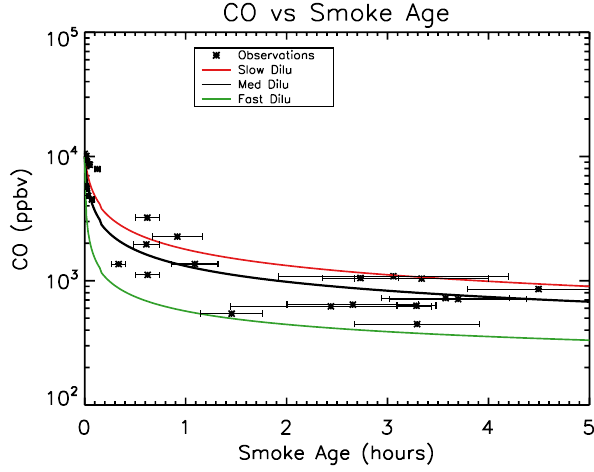
Figure 3. CO mixing ratio (ppbv) vs. smoke age. Red, black, and green are for the slow, best fit (medium), and fast plume dilution rates. Asterisks are the measured mixing ratios, with the horizontal error bars showing the uncertainty in the estimated age, which is much larger than the uncertainty in the CO mixing